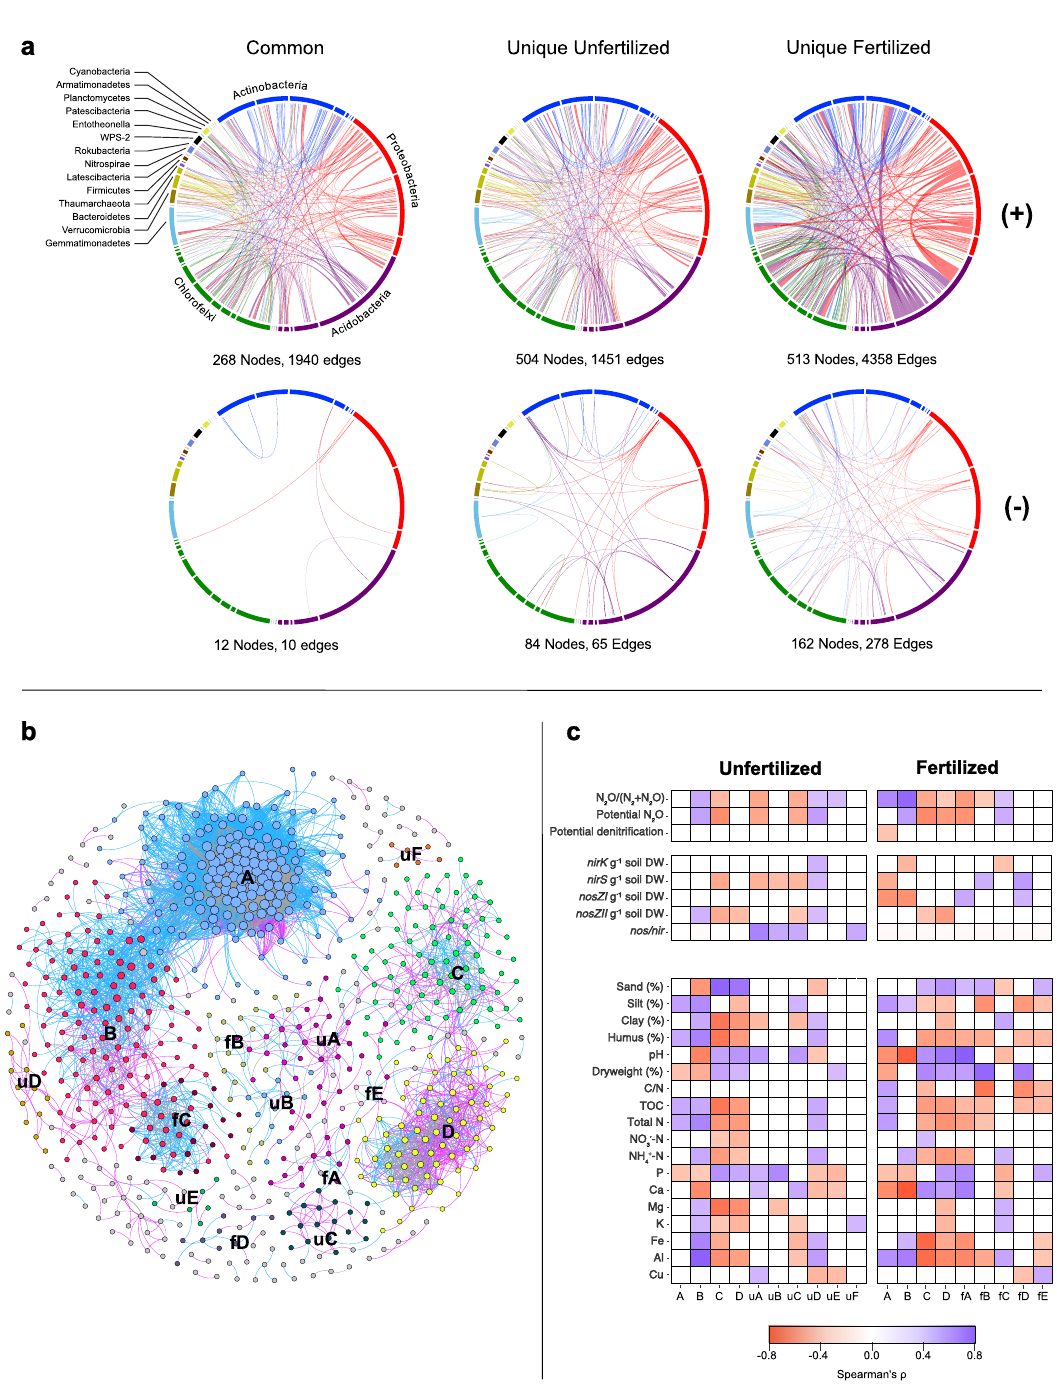
Fig. 3 Co-association networks of OTUs in fertilized and unfertilized soils. a Taxonomic groups at the class level are represented by coloured segments in the outer ring, and ribbons represent signi fi cant co-association ( + ) or exclusionary ( − ) relationships between the different taxonomic groups. The width of the ribbons is proportional to the number of links between the OTUs within each segment, while colour indicates which segment of the two has a higher number of total links. Note that the number of nodes in common and unique subgraphs may overlap; only the number of edges are non-overlapping. b Comparison of fertilized and unfertilized co-occurrence network topologies by network alignment. Nodes are grouped into modules detected in both fertilized and unfertilized networks, where node colour indicates module membership and edge colour corresponds to co-associations that are unique to unfertilized (pink) or fertilized networks (blue), or common to both networks (grey). c Heatmaps show the correlation of module eigenvalues in each network with potential activities and abundances of denitrifying and N 2 O reducing communities, as well as soil edaphic factors. Tile colour re fl ects the strength and direction (blue = positive, red = negative) of correlations, and non-signi fi cant correlations (Spearman ’ s ρ , P > 0.05; N = 51 and N = 54 independent samples for unfertilized and fertilized soils, respectively) are left